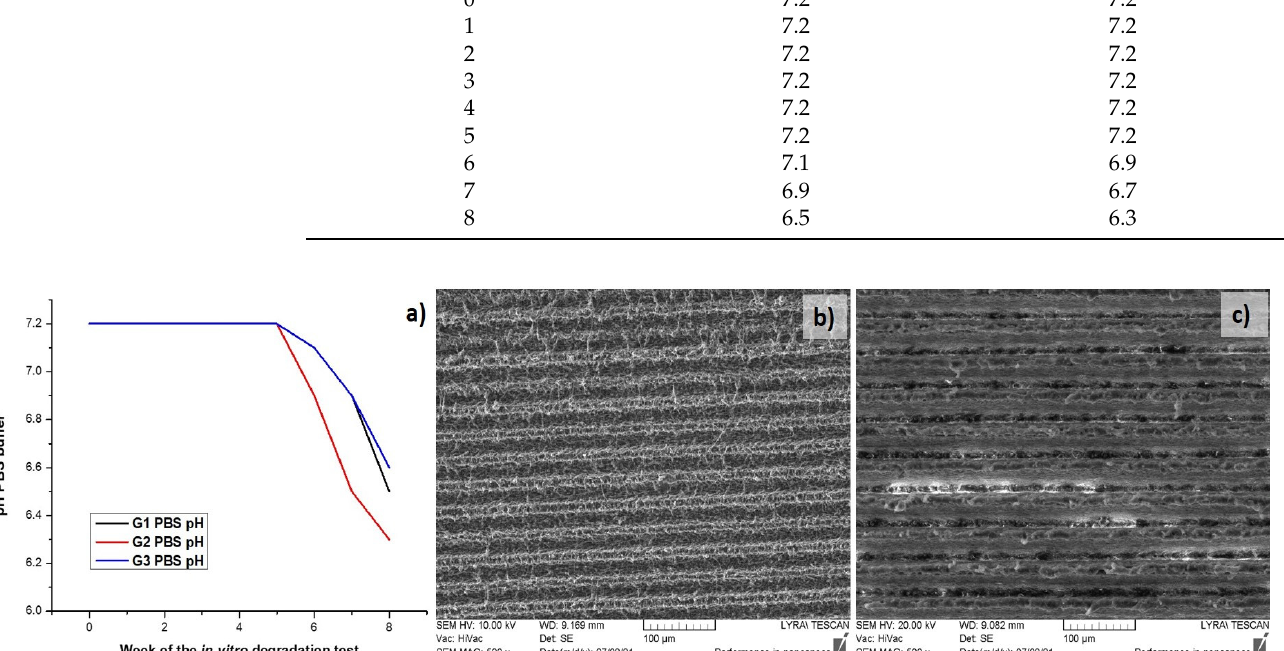
Figure 13. ( a ) Graphical presentation of pH change of PBS of Group1, 2 and 3 over time; ( b ) SEM images of G1, ( c ) G2 samples after the in vitro degradation test. samples after the in vitro degradation